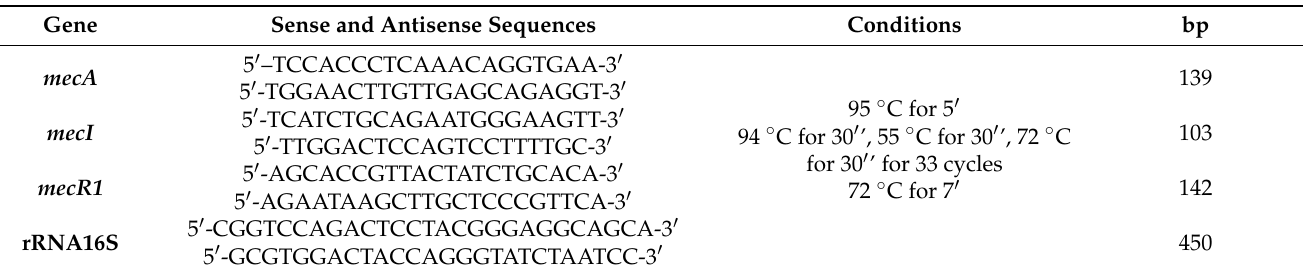
Table 2. Staphylococcal sense and antisense primer sequences and expected PCR products (bp: base pairs). Gene Sense and Antisense